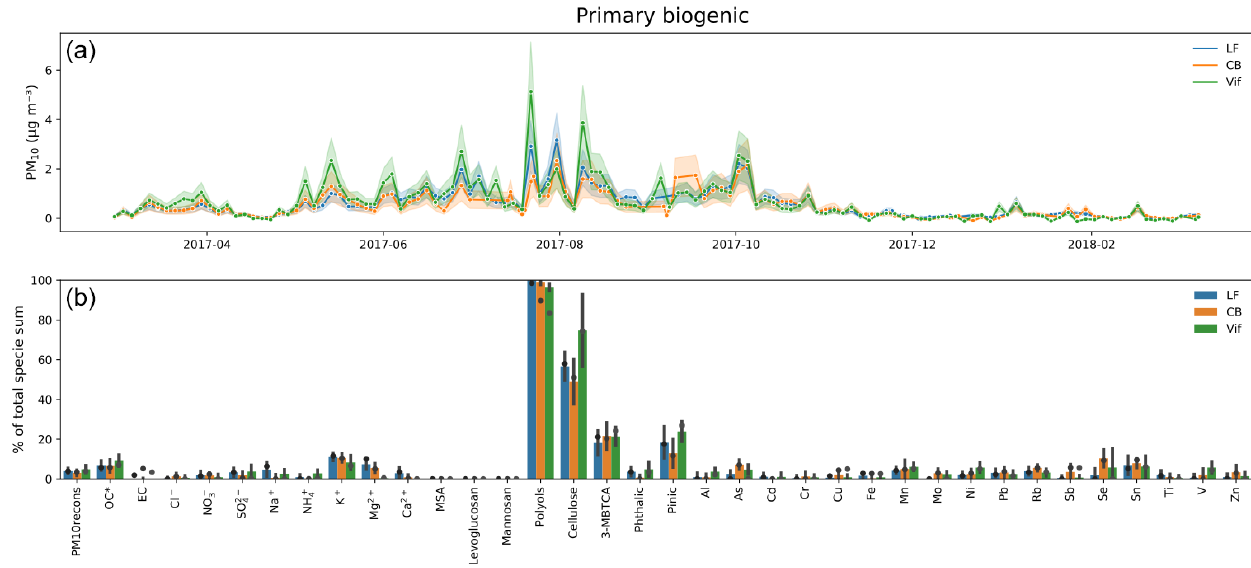
Figure 5. Primary biogenic factor for the three urban sites. (a) Contribution to PM 10 given the mean and standard deviation of the 100 BS. (b) Percentage (%) of each species apportioned by this factor (dots refer to the constrained run, bar plots refer to the mean, and error bars refer to the standard deviation of the 100